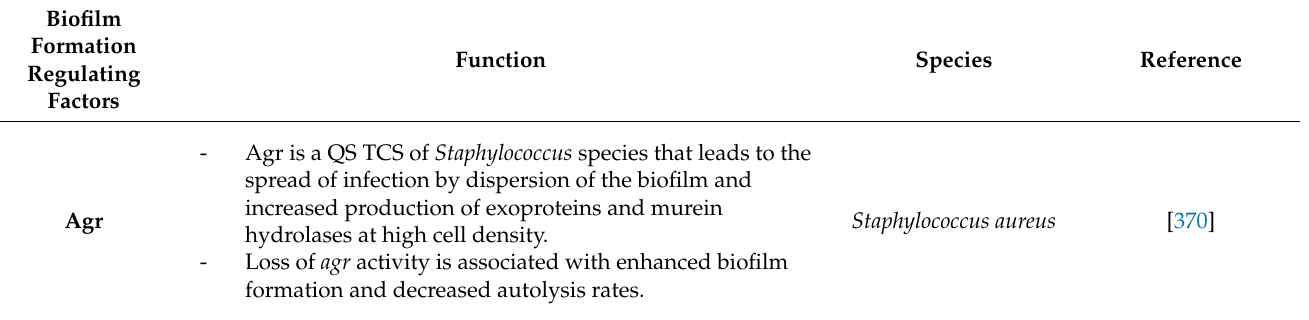
Table 3. Examples of regulatory factors including two-component systems (TCSs) affecting biofilm